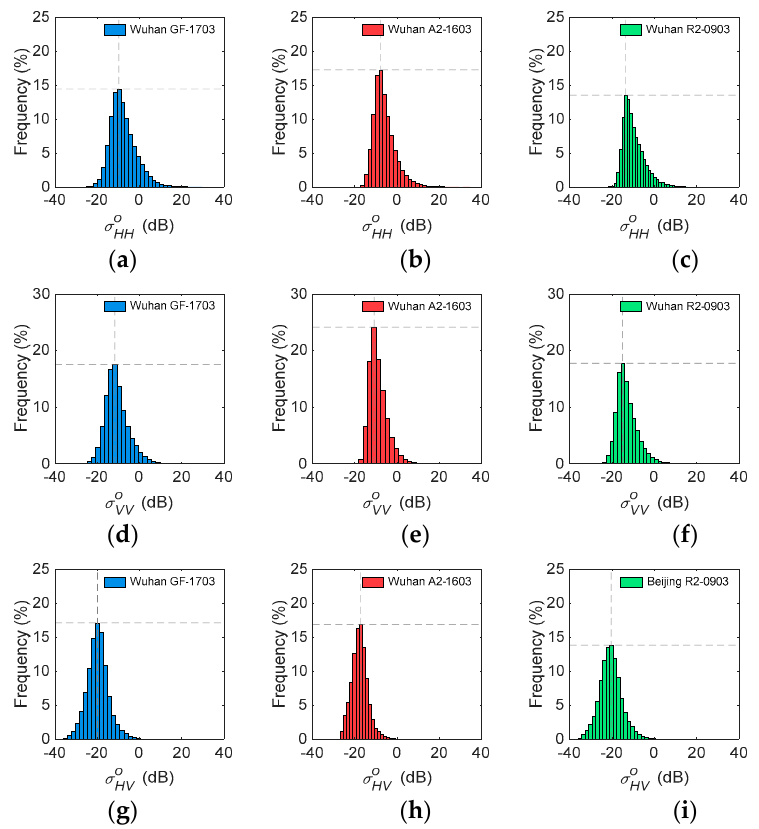
( a – c ), σ o ( d – f ), and σ o ( g – i ) HH VV HV